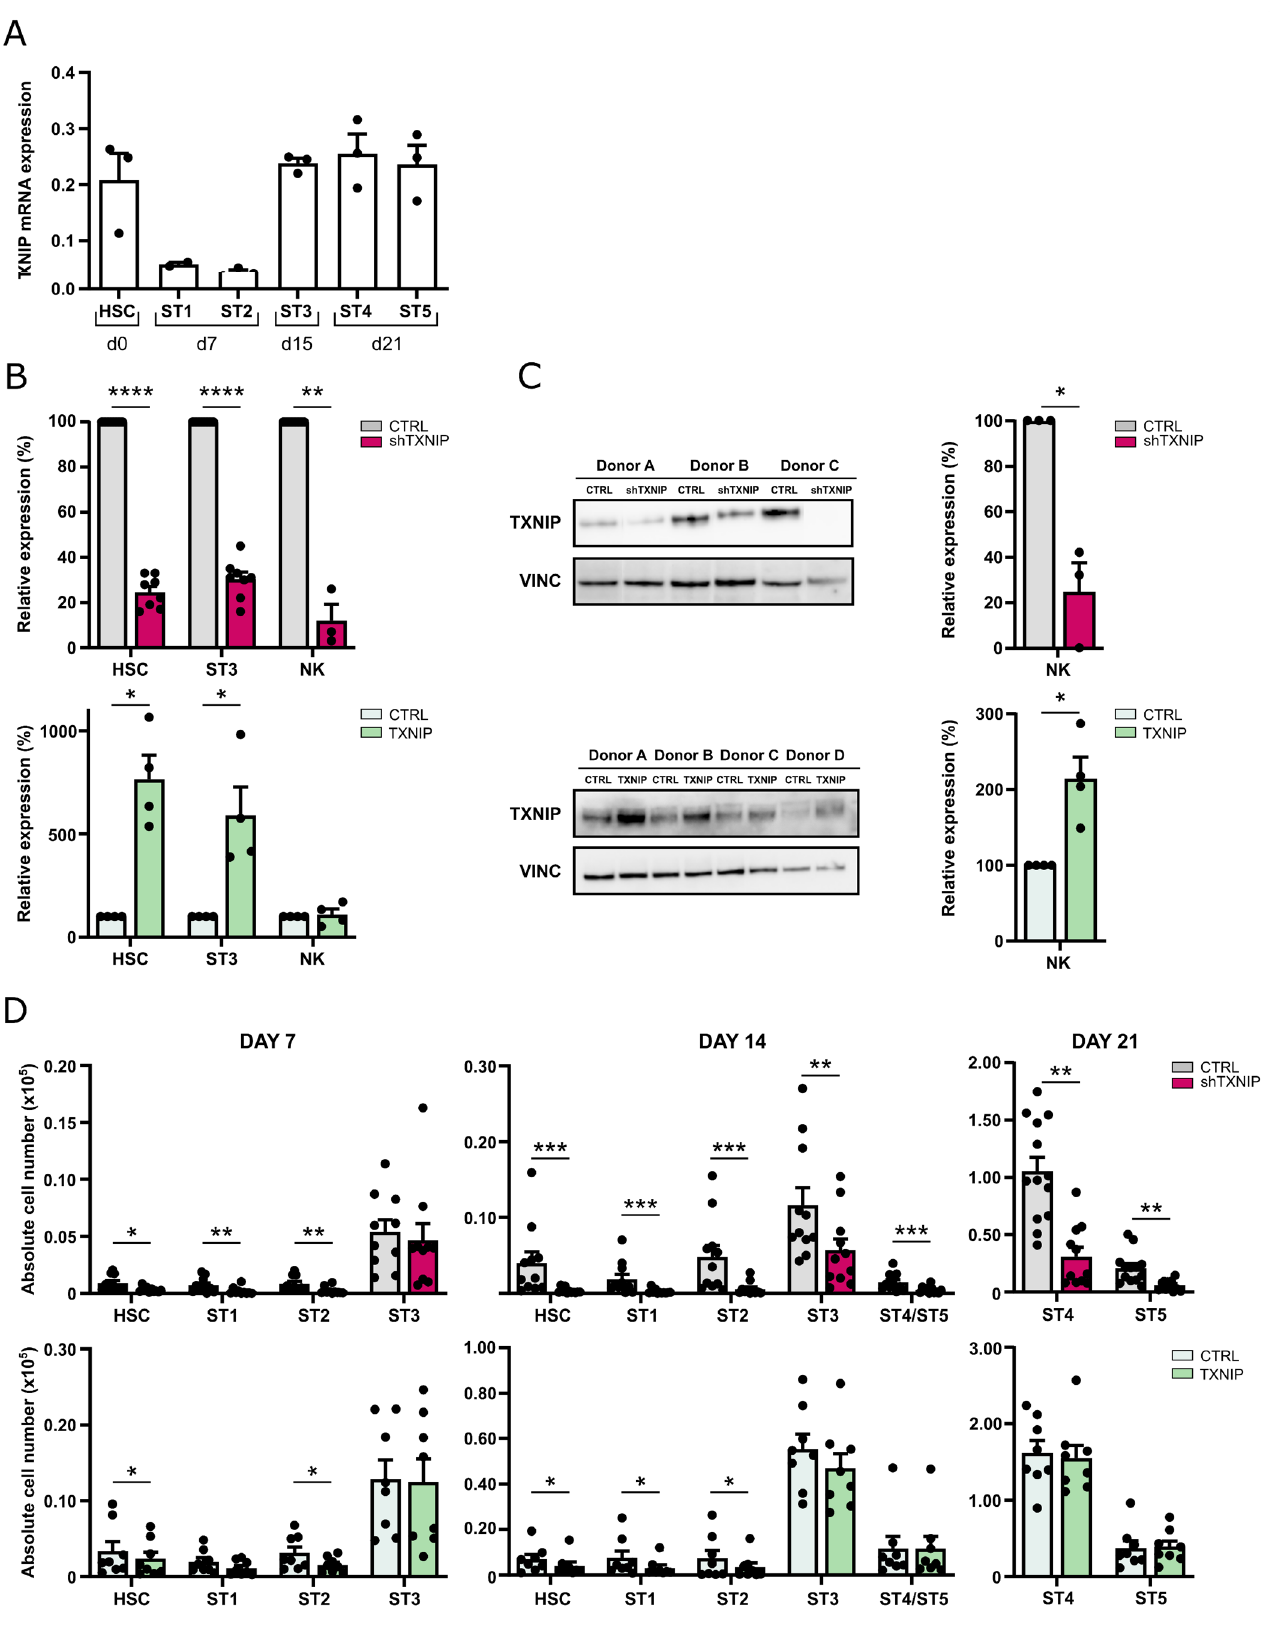
Figure 1. TXNIP promotes human NK cell development. ( A ) TXNIP expression was determined using RT-qPCR in the indicated successive NK cell developmental stages sorted from HSC-based in vitro NK cell differentiation cultures: HSC (Lin − CD34 + CD45RA − ) sorted on day (d)0, stage (ST) 1